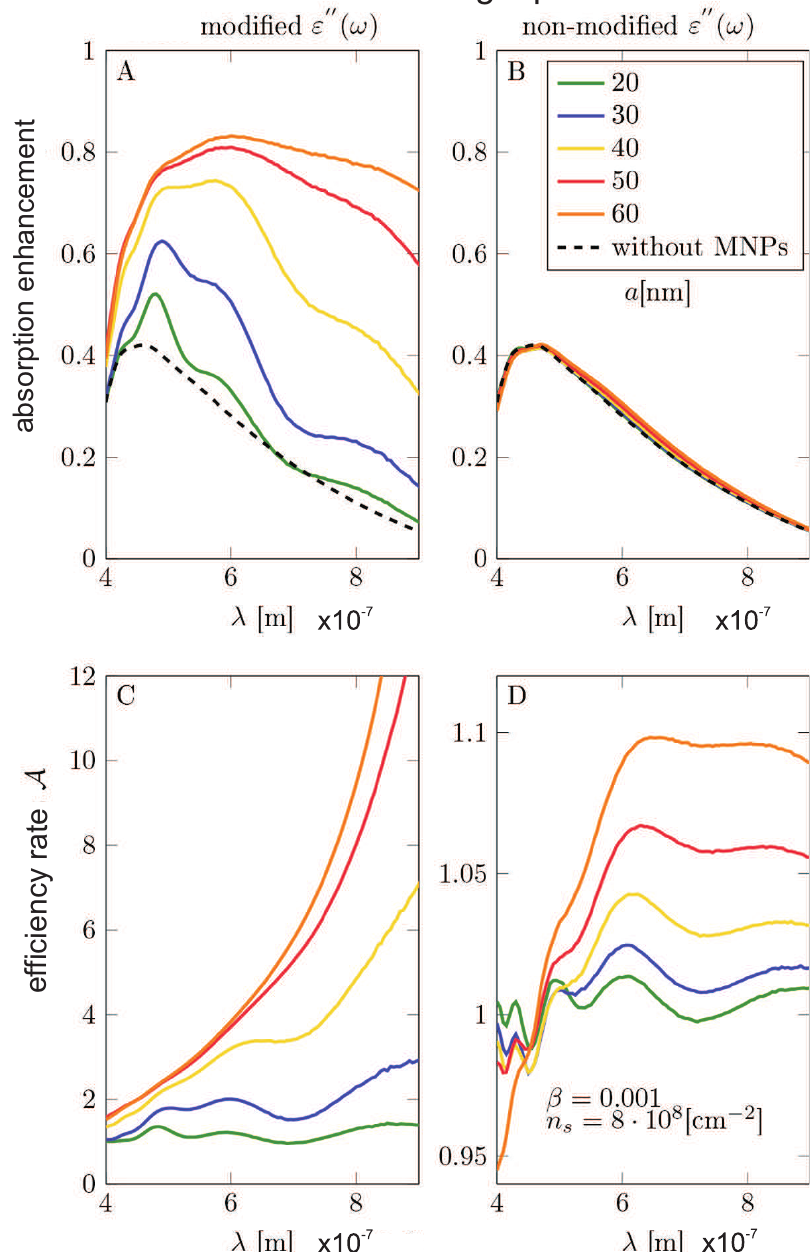
Figure 8. Single particle model—( A , B ): The absorption growth in the Si substrate as a function of the wavelength of incident electromagnetic wave for varying radius of metallic nanoparticles ( Λ accommodated to conserve surface density n s = 8 × 10 8 /cm 2 ). ( C , D ): The efficiency enhancement factor acc. Equation (27) as a function of the wavelength of incident electromagnetic wave for varying size of nanoparticles and constant their concentration. ( A , C ): Results obtained in the model using ′′ ( ω ) . ( B , D ): Results obtained in the model using non-modified irrelevant dielectric function modified ε measured in bulk [42]. The calculations were made for on Si substrate deposited single MNP with radii a = 20, 30, 40, 50, 60 nm, β = 0.001 and for MNP effective (accommodated by Λ ) concentration n s = 8 × 10 8 /cm 2